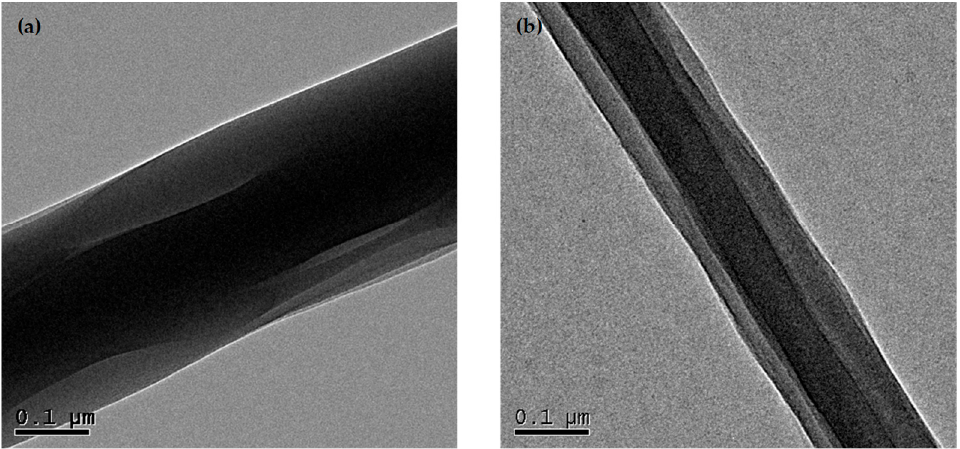
Figure 4. TEM photographs of the TPP loaded core-shell fibers with the different weight ratios (DCM/DMF) (( a ) 9:1; ( b ) 5:5) at core solution flow rate of 0.2 mL/h.